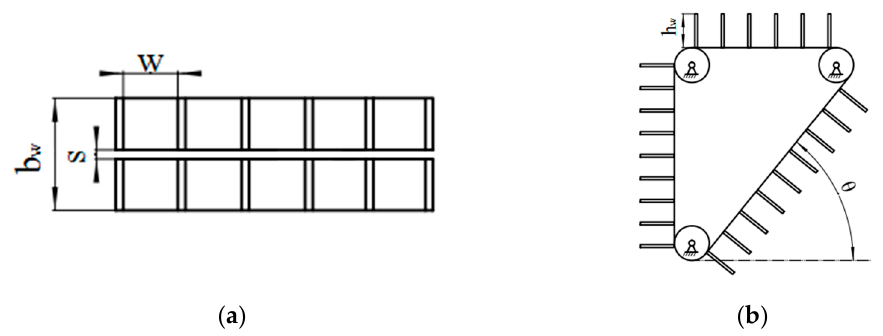
Figure 14. Schematic diagram of the double-equidistant-baffle conveyor belt: ( a ) top view; ( b ) pri- mary view.